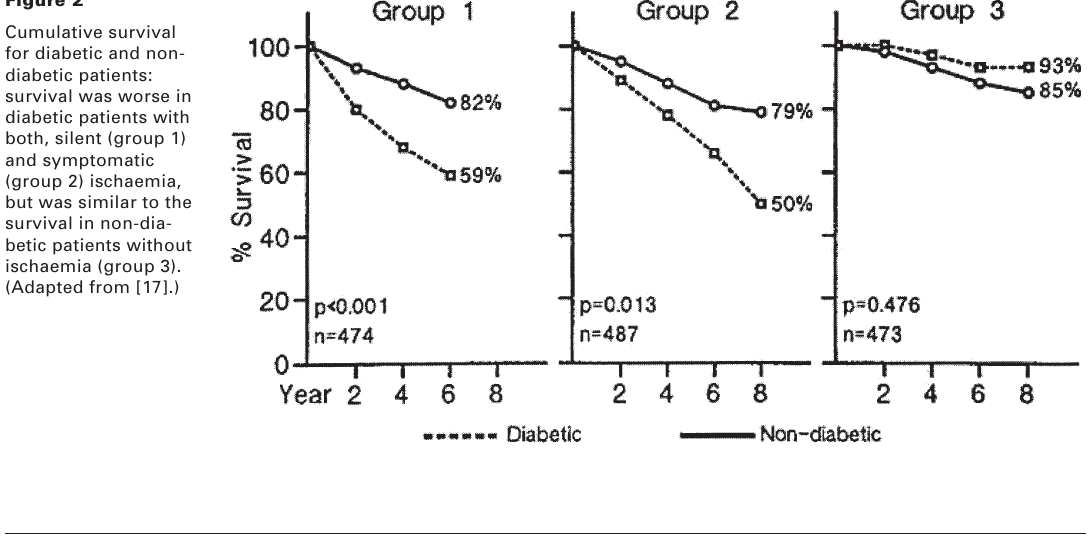
Cumulative survival for diabetic and non- diabetic patients: survival was worse in diabetic patients with both, silent (group 1) and symptomatic (group 2) ischaemia, but was similar to the survival in non-dia- betic patients without ischaemia (group 3). (Adapted from